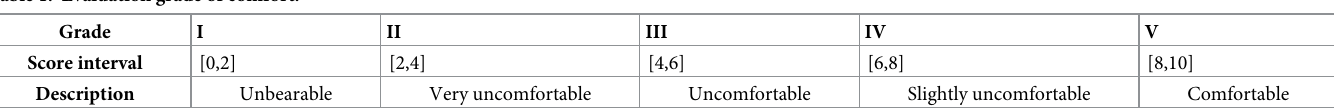
There are 5 score intervals of comfort, each of which is 2 in length and the total length of the interval is 10. Experts score each index according to the comfort level of the automobile cockpit, with the score controlled to one decimal